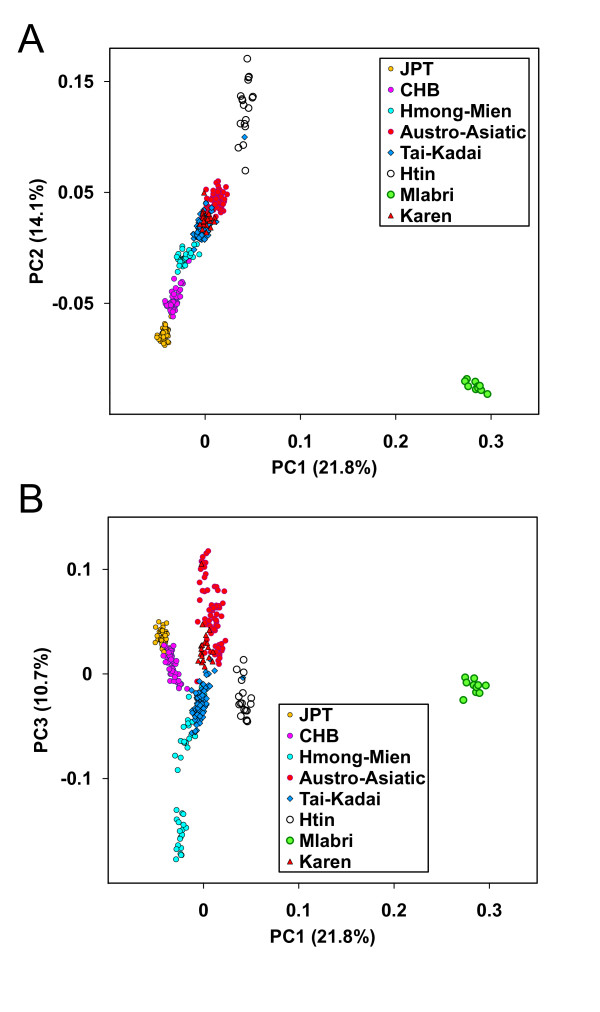
Plot of Principal Components for 446 individuals representing 15 populations. Individuals are shaded by different colors according to their predefined population affiliations, and the legend is displayed on the lower right of the plot. A: plot of the first two principle components. B: plot of the first and the third principle components.